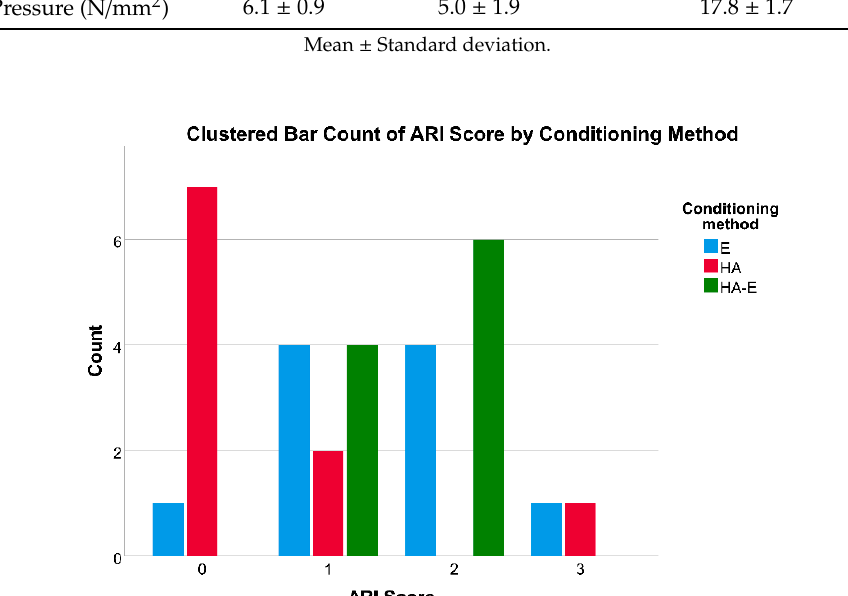
Figure 3. Histogram reporting the frequency of ARI scores for the acid etching (E) group, for the hydroabrasion group (HA), and for the hydroabrasion and acid etching (HA-E) group. ARI, adhesive remnant index according to Årtun and Bergland; Score = 0 no adhesive left on the tooth; Score 1 = less than half of the adhesive left on the tooth; Score 2 = more than half of the adhesive left on the tooth; Score 3 = all adhesive left on the tooth, with distinct impression of the bracket mesh.